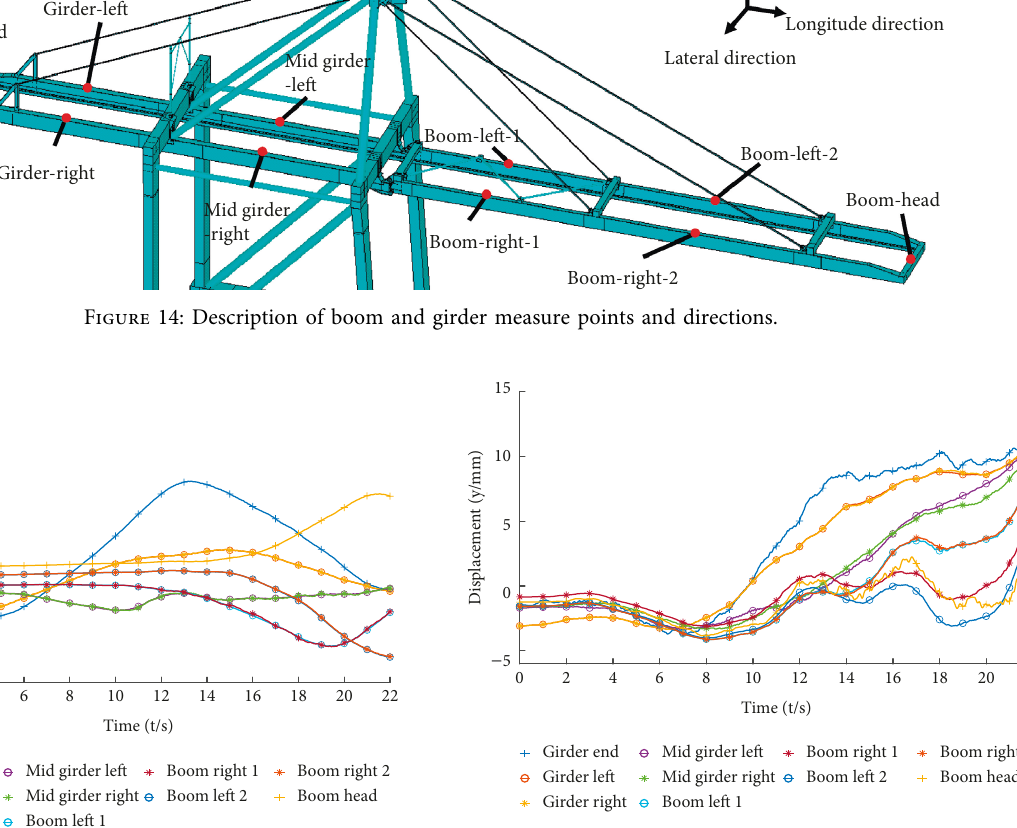
Figure 15: Time series of vertical displacement of girder at full length.